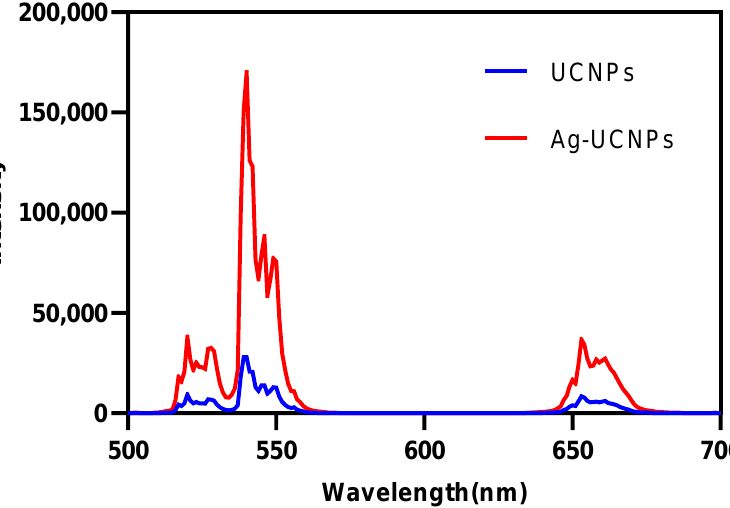
Figure 6. Luminescent intensity of UCNPs and Ag-UCNPs.